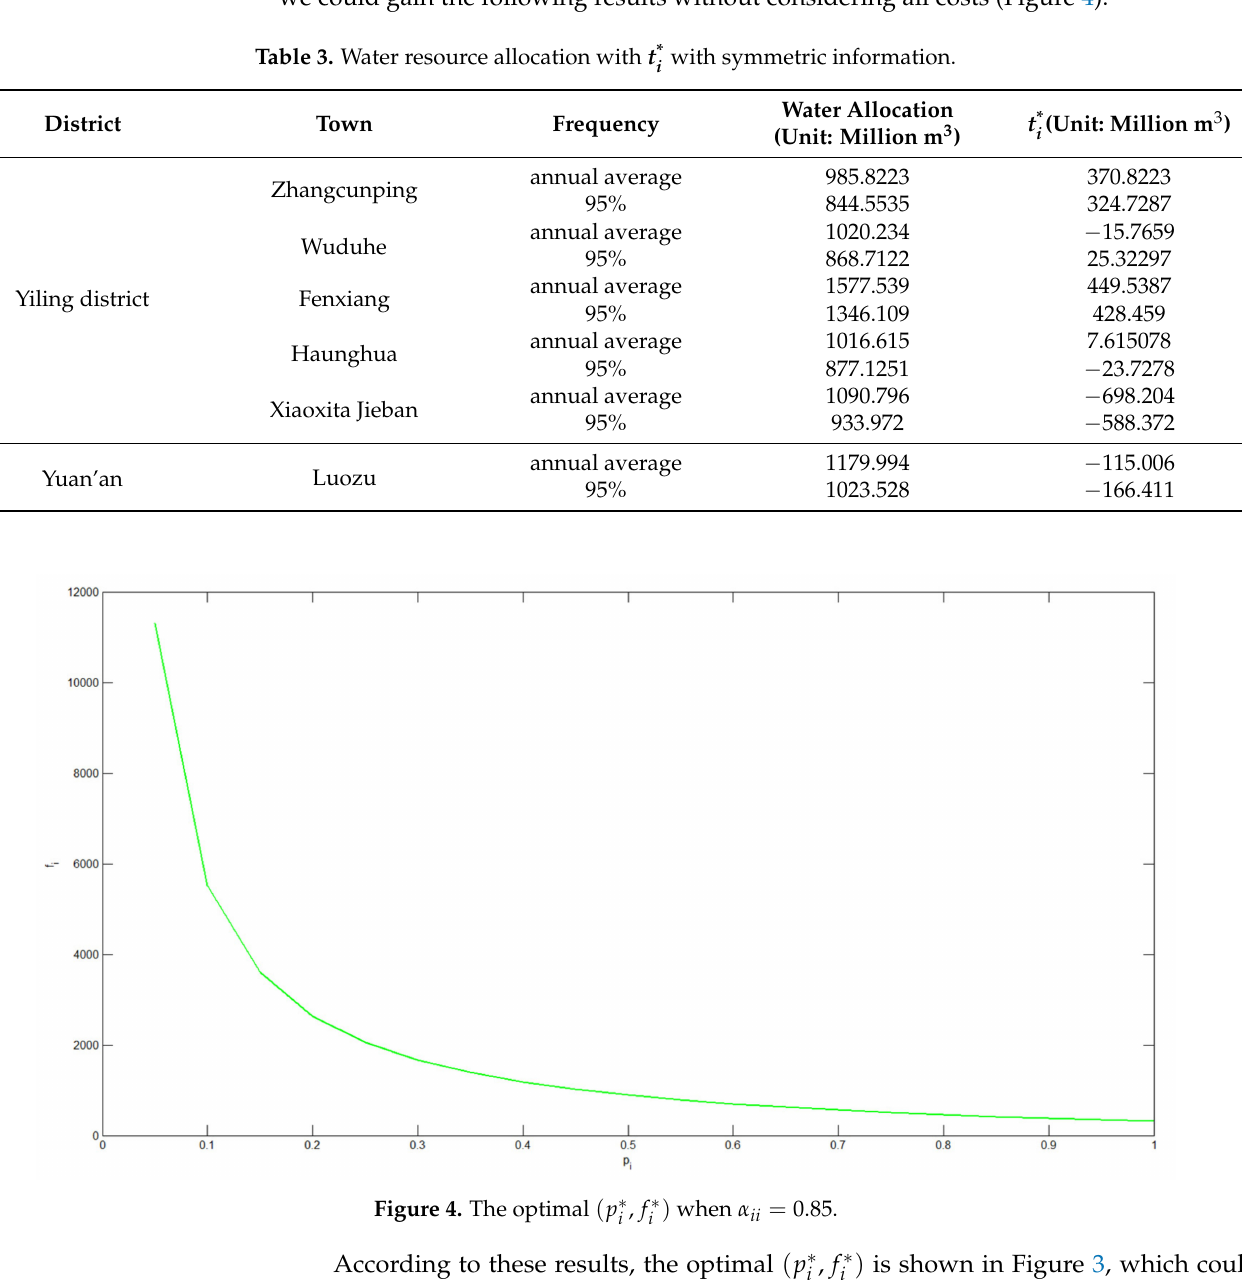
Table 3. Water resource allocation with t *